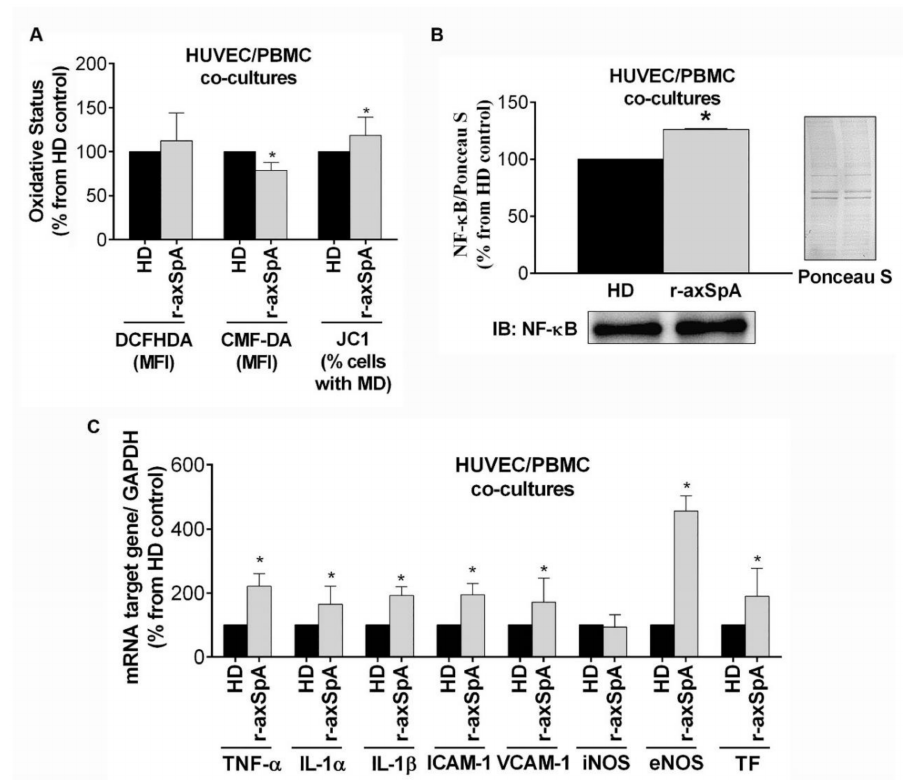
Figure 4. Analysis of the effect of PBMCs from r-axSpA patients on endothelial activation. ( A – C ) Peripheral blood mononuclear cells (PBMCs) isolated from r-axSpA patients ( n = 5) and HDs ( n = 5) were cocultured with human umbilical vein endothelial cells (HUVECs) for 24 h. ( A ) Peroxide production, intracellular glutathione (GSH) levels, and mitochondrial membrane potential in HUVECs. ( B ) Nuclear factor- κ B (NF- κ B) protein expression in HUVECs. ( C) Expression levels of a panel of NF- κ B target genes in HUVECs. Values are presented as means ± SD. The data were analyzed using an independent samples t -test or a Mann–Whitney U test. * vs. HDs ( p < 0.05). eNOS, endothelial nitric oxide synthase; HDs, healthy donors; ICAM, intercellular adhesion molecule; IL, interleukin; iNOS, inducible nitric oxide synthase; r-axSpA, radiographic axial spondyloarthritis; TNF, tumor necrosis factor; TF, tissue factor; VCAM, vascular cell adhesion